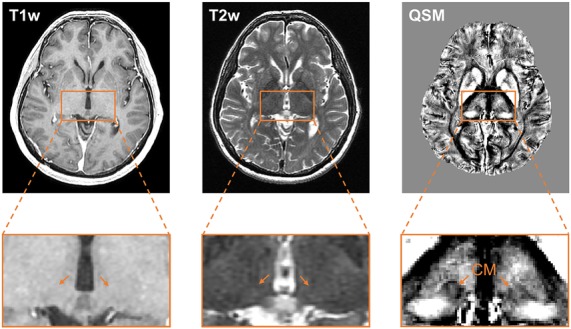
Comparison of the visualization of the CM nucleus on T1w, T2w, and QSM images. Axial slice views (upper row) and enlarged views of the thalamus (lower row) on T1w, T2w, and QSM images at one representative section on a representative patient. Abbreviations: CM, centromedian nucleus; QSM, quantitative susceptibility mapping.